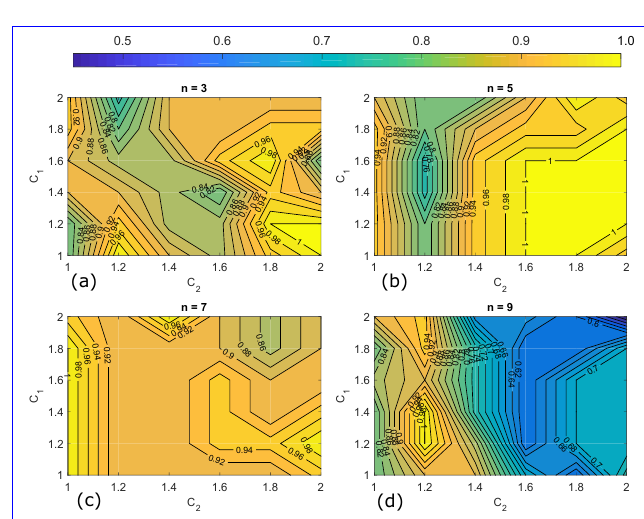
Figure 8. Success rate mapping for different number of particles (a) n = 3 : 5 pairs with SR = 100% . (b) n = 5 : 13 pairs with SR = 100% . (c) n = 7 : 7 pairs with SR = 100% . (d) n = 9 : 2 pairs with SR = 100% .